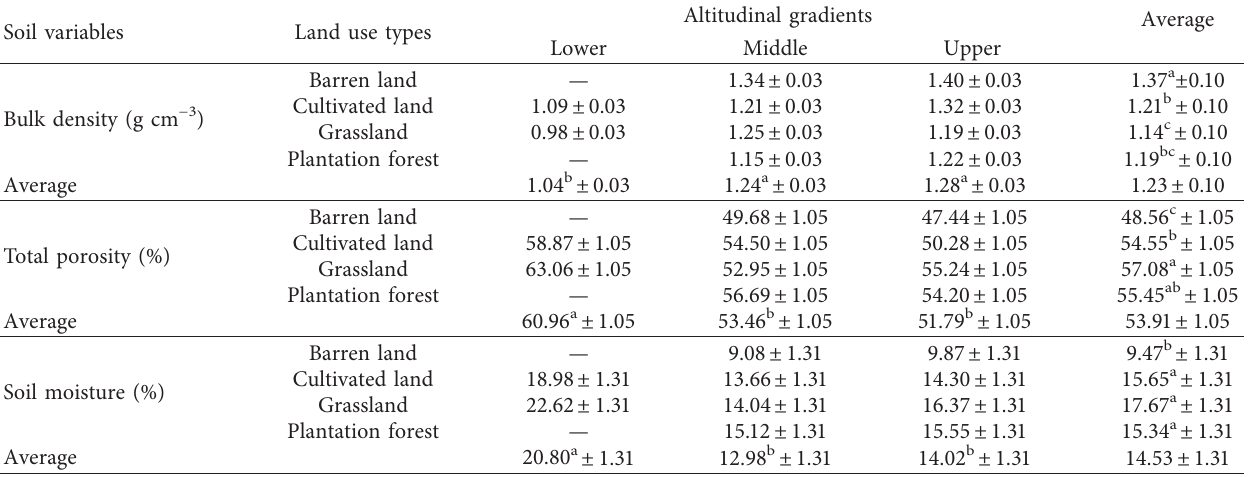
Table 3: Mean values ± SE of soil bulk density, total porosity, and soil moisture in different land use types across altitudinal gradients. Soil